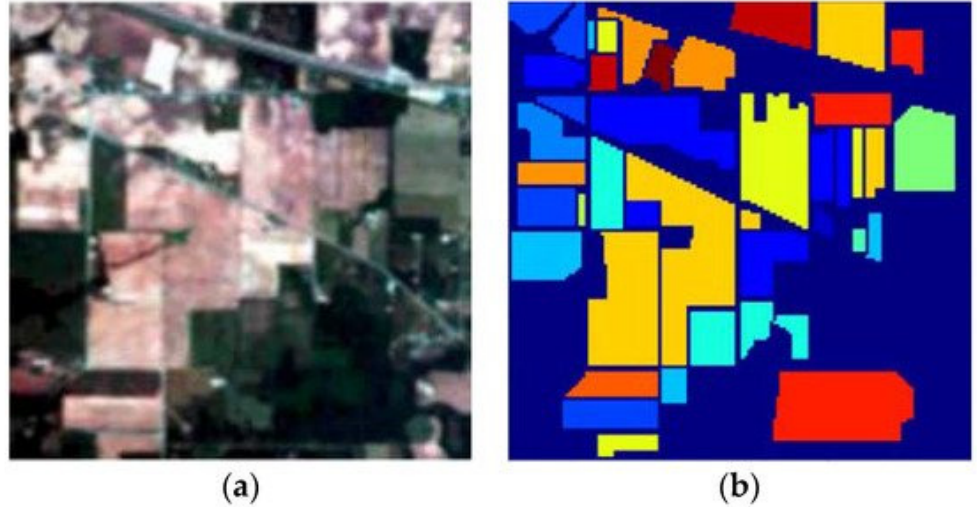
Figure 10. Detection of Areas in Indian Pines Dataset: ( a ) Segmented Image; ( b ) Detection.